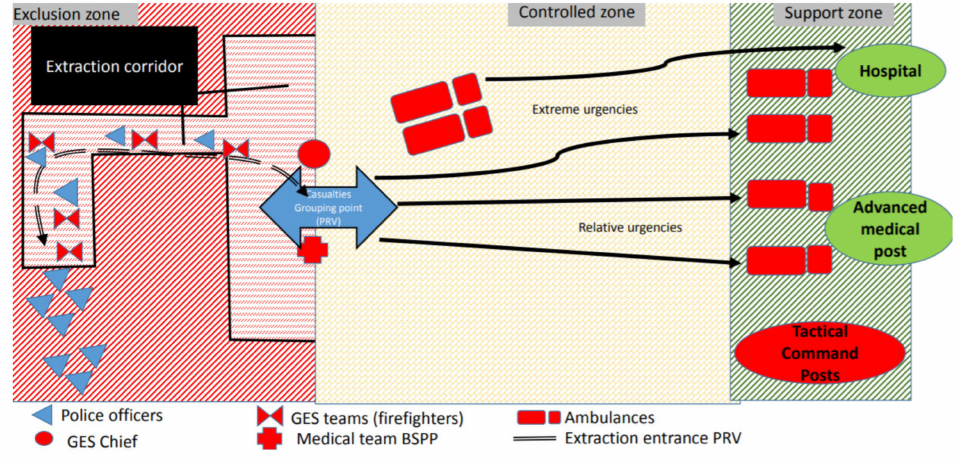
Figure 19. ERs’ actions on the field [60].